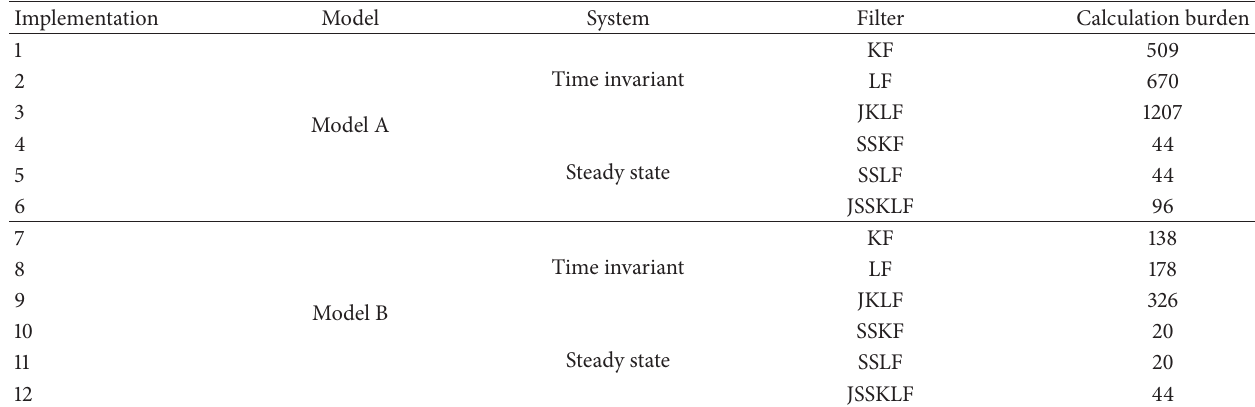
Table 3: Per-iteration calculation burden of